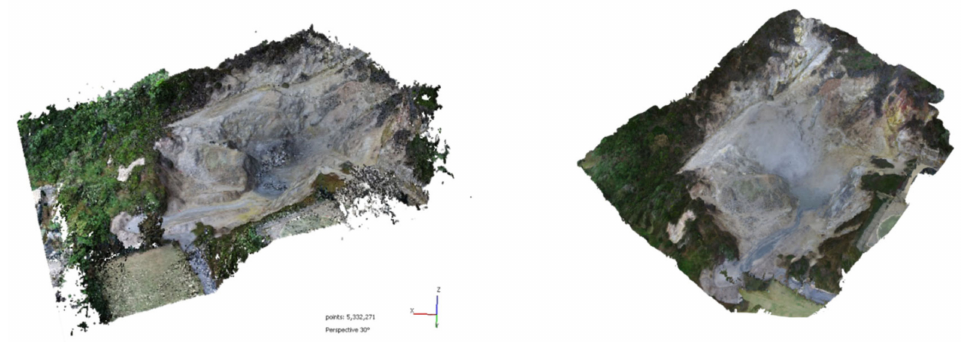
Figure 5. Three-dimensional point clouds ( left ) and 3D model of Pisciarelli fumarolic field ( right ).